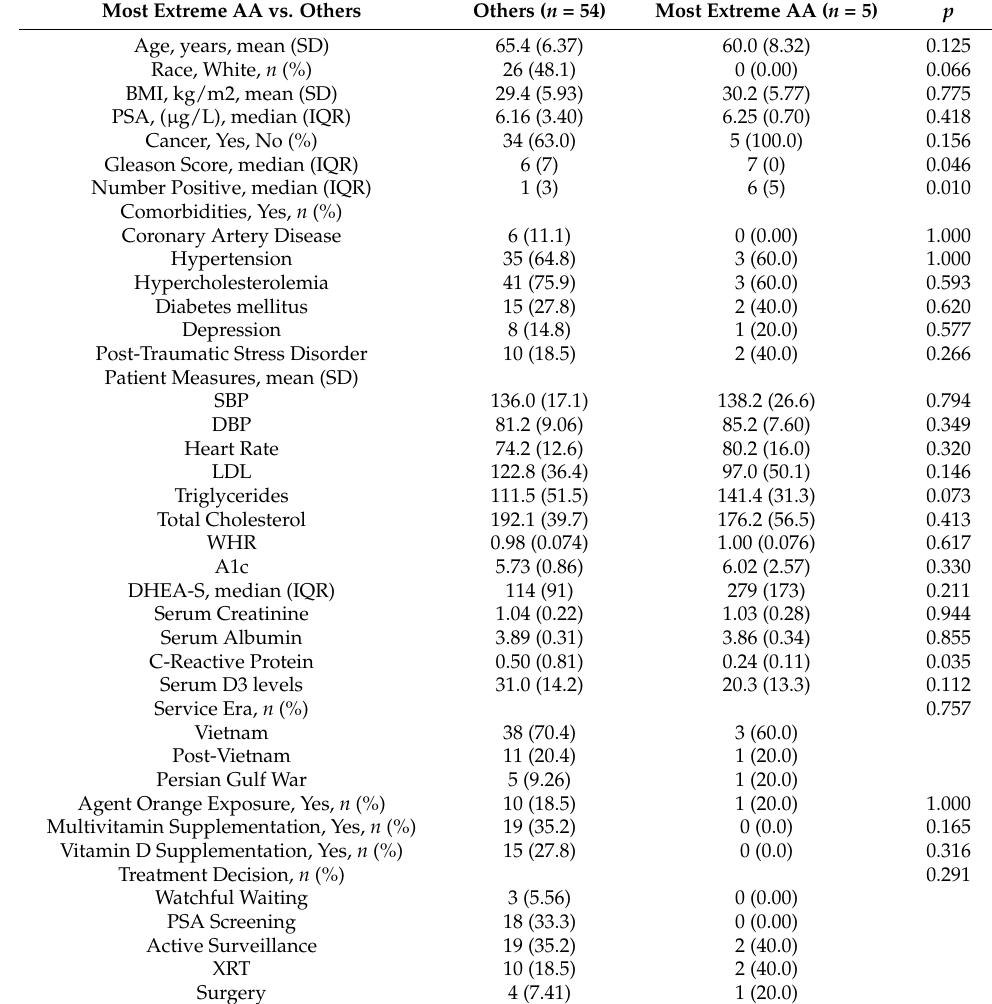
Table 3. Patient characteristics of the five most extreme AA patients compared to patients ( n = 54) who did not cluster with these five